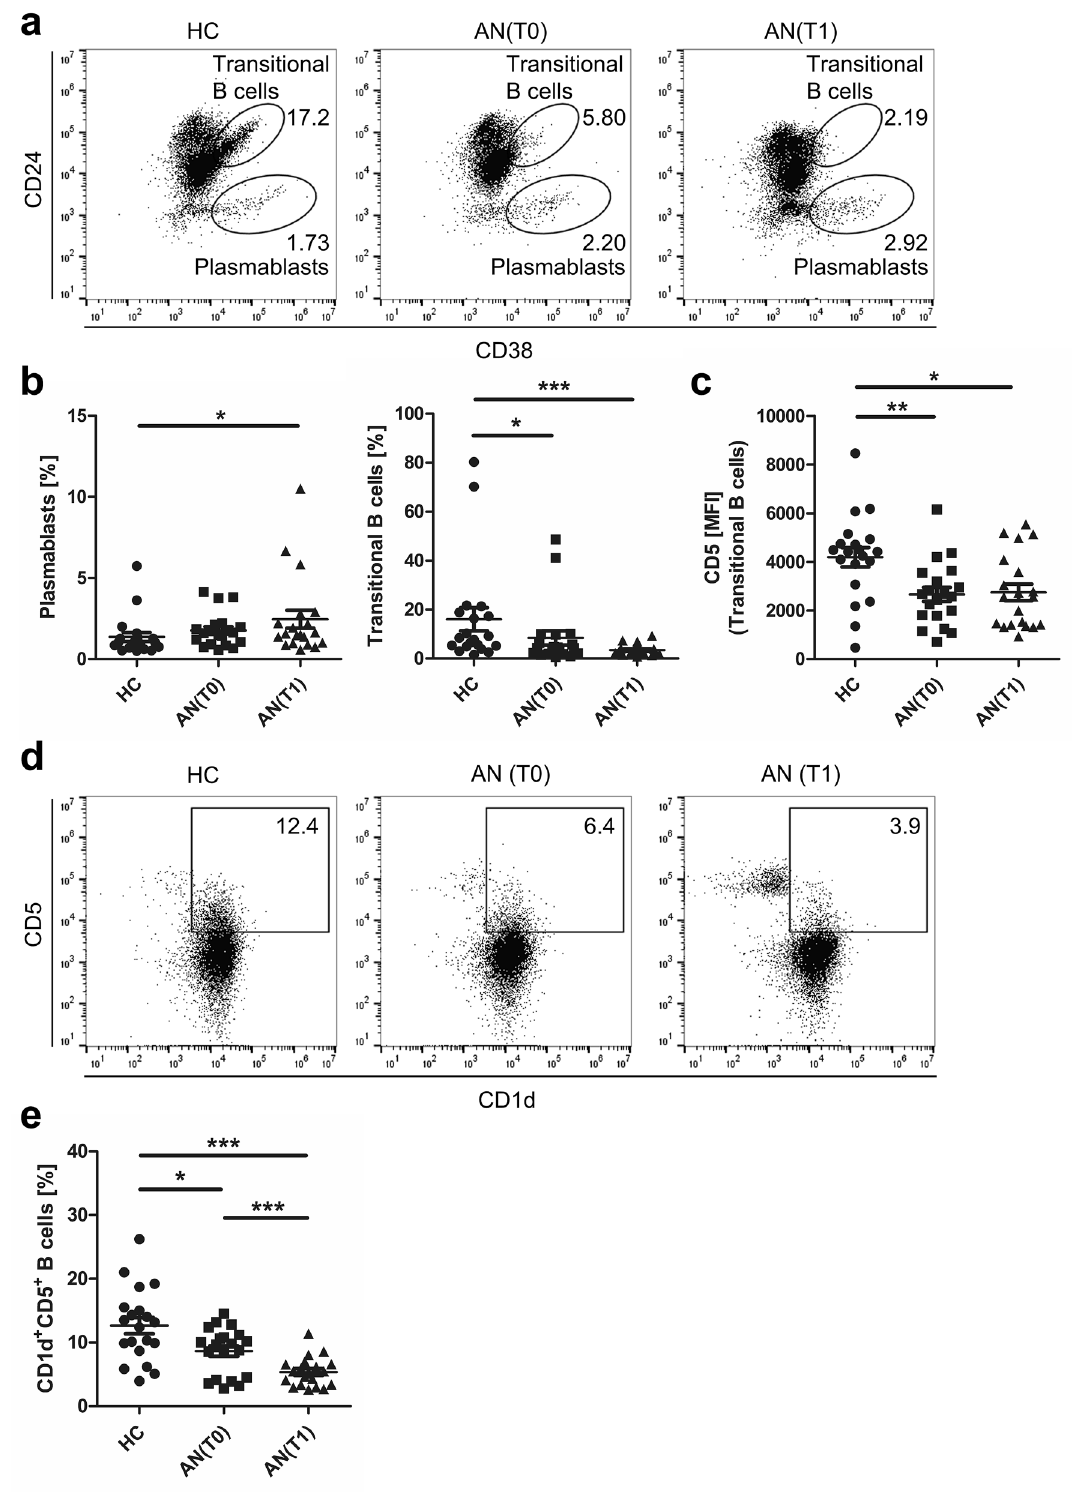
Figure 4. Plasmablasts and transitional B cells and CD1d + CD5 + B cells in PBMC of healthy controls (HC) and adolescents with anorexia nervosa (AN). ( a ) Representative dot plots of a HC and patients with AN showing CD24 + CD38 hi transitional B cells and CD24 − CD38 + plasmablasts, pre-gated on CD45 + CD19 + B cells. Graphs displaying ( b ) frequencies of CD24 + CD38 hi transitional B cells and CD24 − CD38 + plasmablasts and ( c ) the mean fluorescence intensity (MFI) of CD5 on transitional B cells in HC (n = 20) and in patients with AN at T0 (n = 20) and at T1 (n = 20). ( d ) Representative dot plots of HC and patients with AN showing CD1d + CD5 + B cells, pre-gated on CD45 + CD19 + B cells. ( e ) Graph displaying frequencies of CD1d + CD5 + B cells in HC (n = 20) and in patients with AN at T0 (n = 20) and after six weeks of multi-modal therapy at T1 (n = 20). P- values vs. HC were calculated by t test for independent samples, T0 vs. T1 by t test for paired samples, * p < 0.05; ** p < 0.01; *** p <